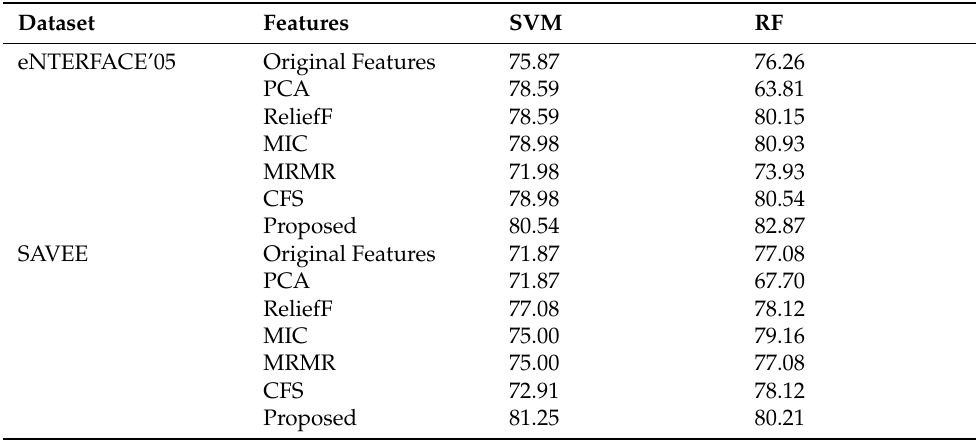
Table 1. Highest recognition rate for each method (%).